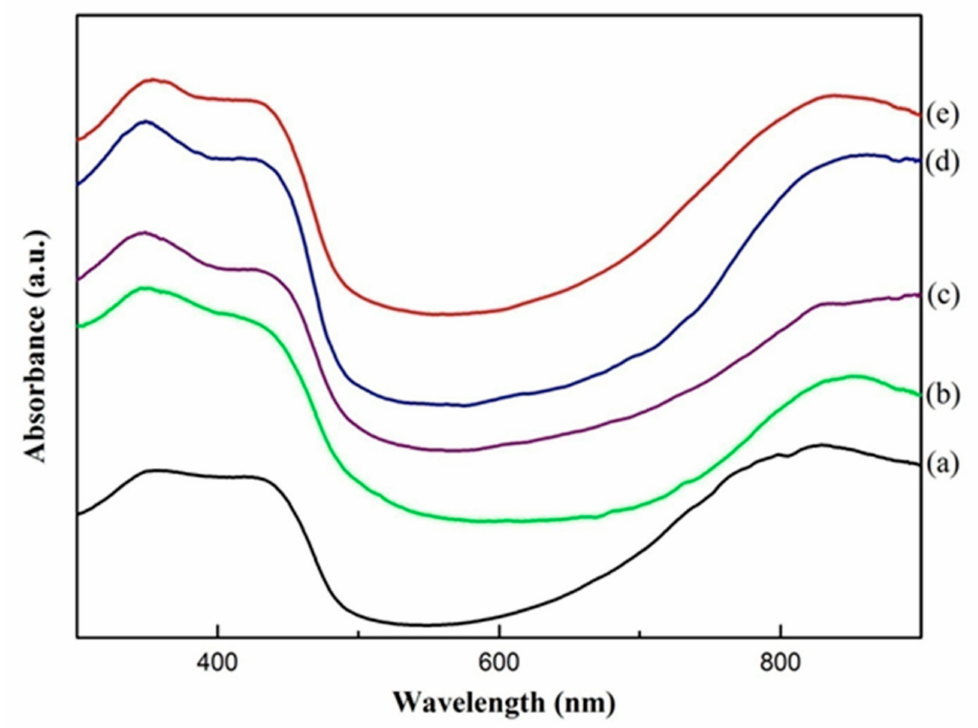
Figure 2. UV-Vis spectra of (a) pure PANDB and conductive PANDB/ χ -Al 2 O 3 nanocomposites synthesized at AN/ χ -Al 2 O 3 weight ratios of (b) 0.5, (c) 1, (d) 1.5, and (e)